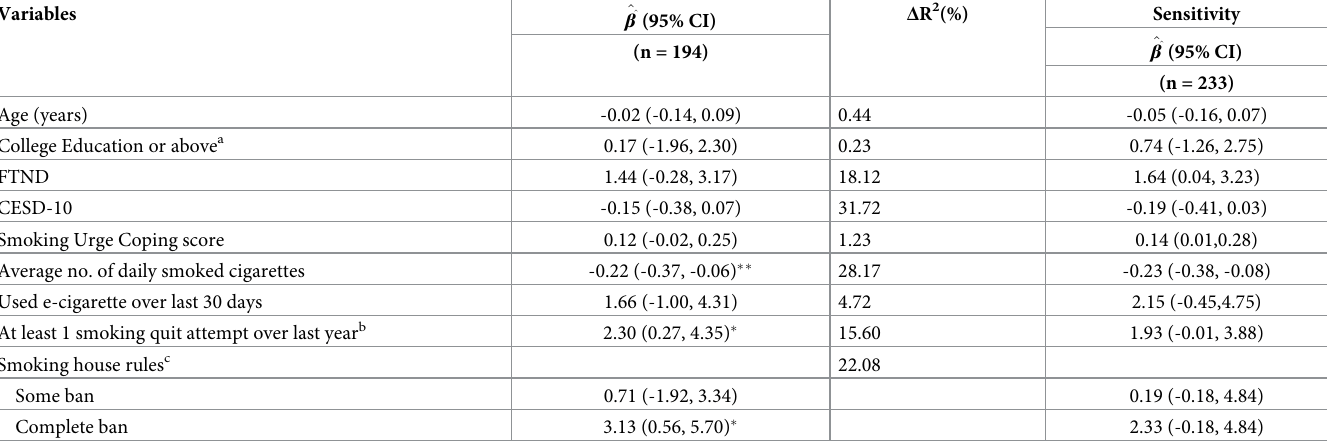
Table 2. Parameter estimates from multivariable linear regression for SEQ-12 score and change in multiple R 2 (%) by exclusion from final